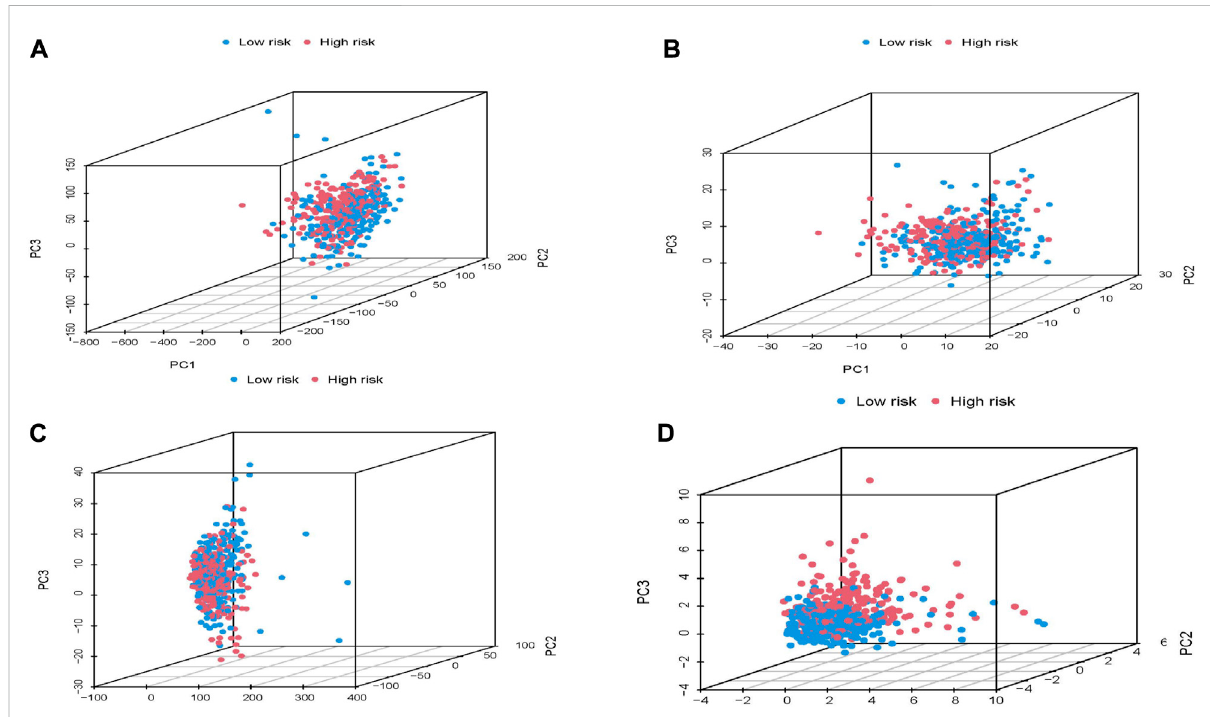
FIGURE 5 Principal component analysis of high and low risk groups based on TCGA whole group. (A) all genes. (B) 417 molecular chaperone genes. (C) 3,597 molecular chaperone-related lncRNAs. (D) 20 molecular chaperone-related lncRNAs in the risk